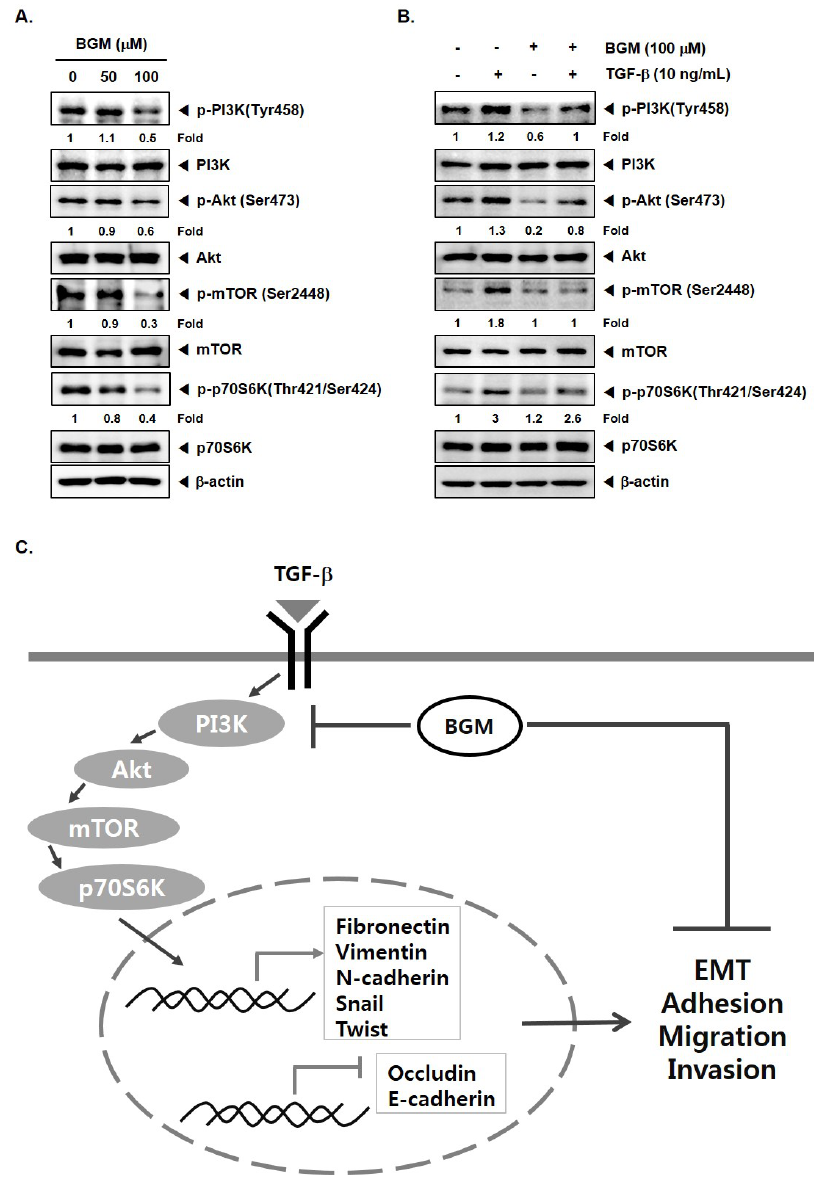
Figure 4. Effects of BGM on Akt activation in TGF- β -treated A549 cells. ( A ) Cells were treated with BGM (50–100 µ M) for 6 h and Western blotting was done to detect changes in the phosphorylation status of various kinases as shown above. ( B ) Cells were treated as described above in panel 2A and Western blotting was carried out. Band intensities were estimated by the Image J software. ( C ) A schematic representation of the proposed targets modulated upon BGM